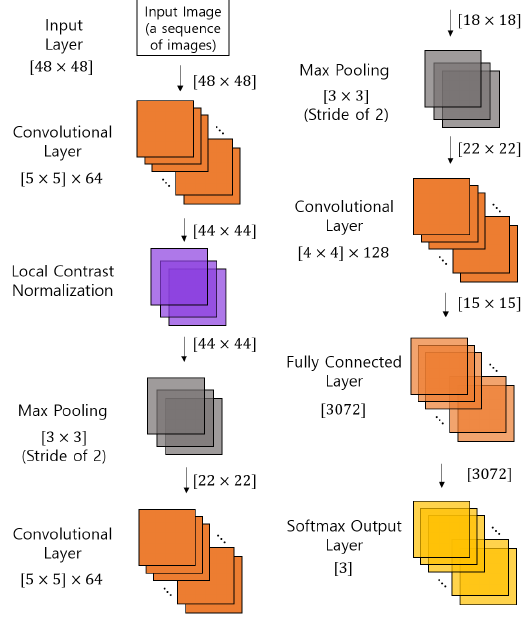
Figure 3. Basic model employed for expression recognition.